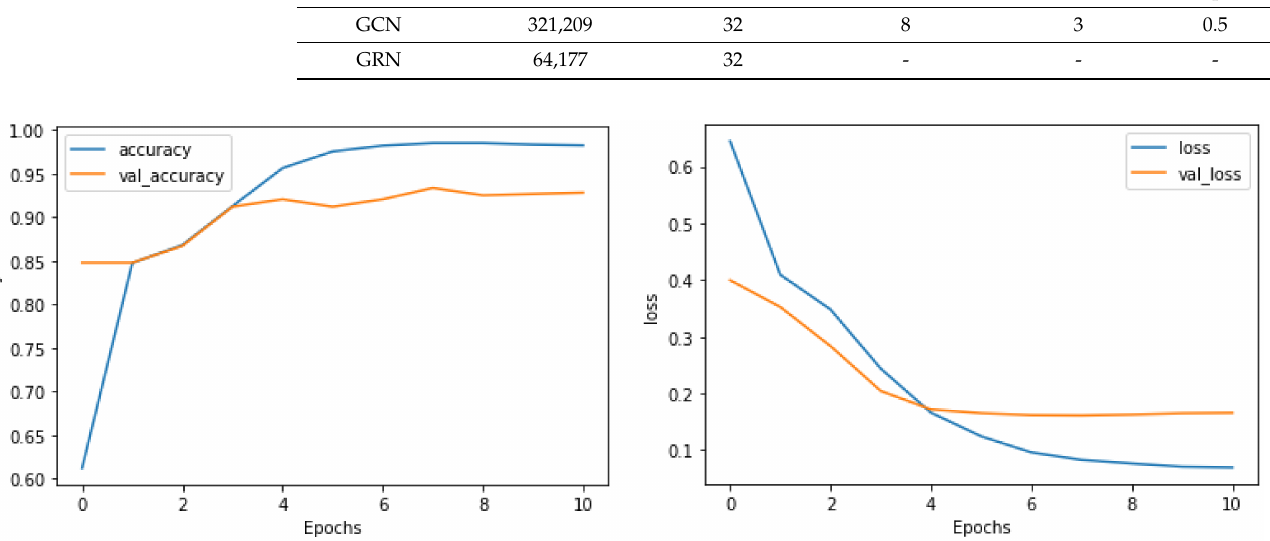
Figure 9. The data training process using